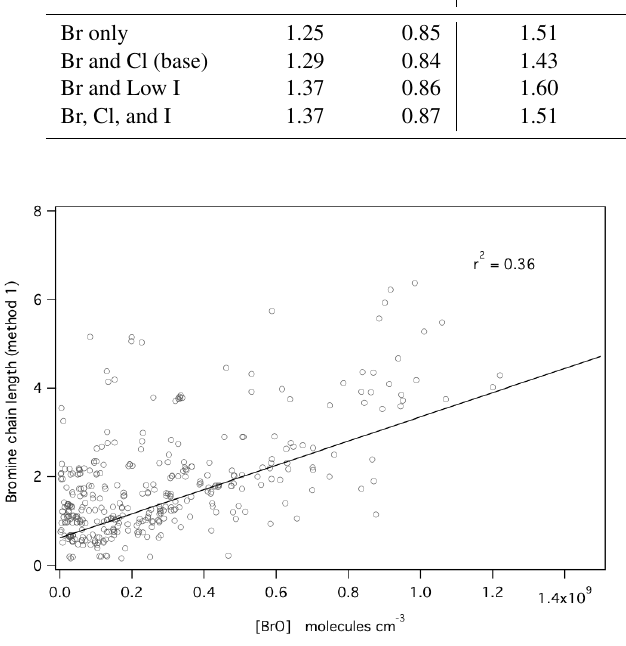
Figure 4. Regression of daytime (07:00–21:00AKST) bromine chain length calculated by Method 1 (Eq. 5) and simulated BrO concentration.